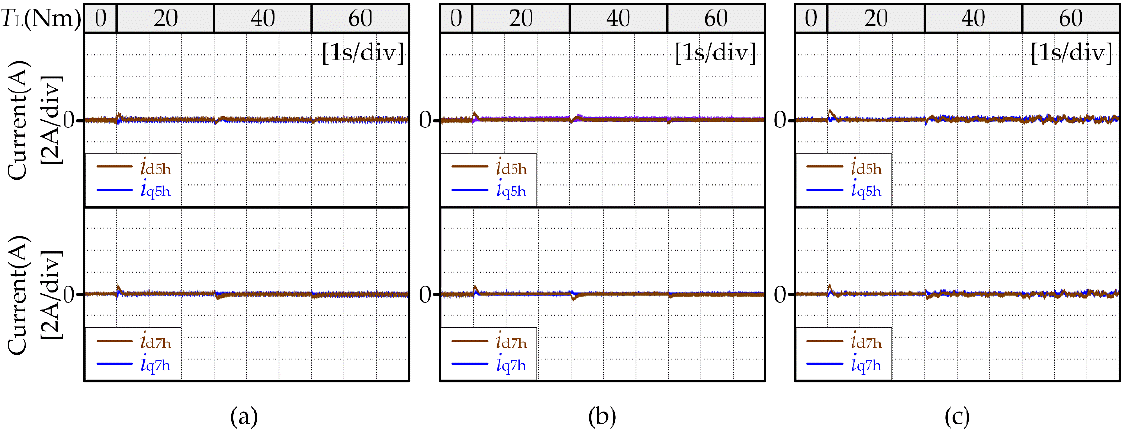
Figure 15. Waveforms of 5th and 7th current harmonic components with proposed current harmonic suppression strategy applied. ( a ) 100 rpm; ( b ) 1000 rpm; and ( c ) 2500 rpm.